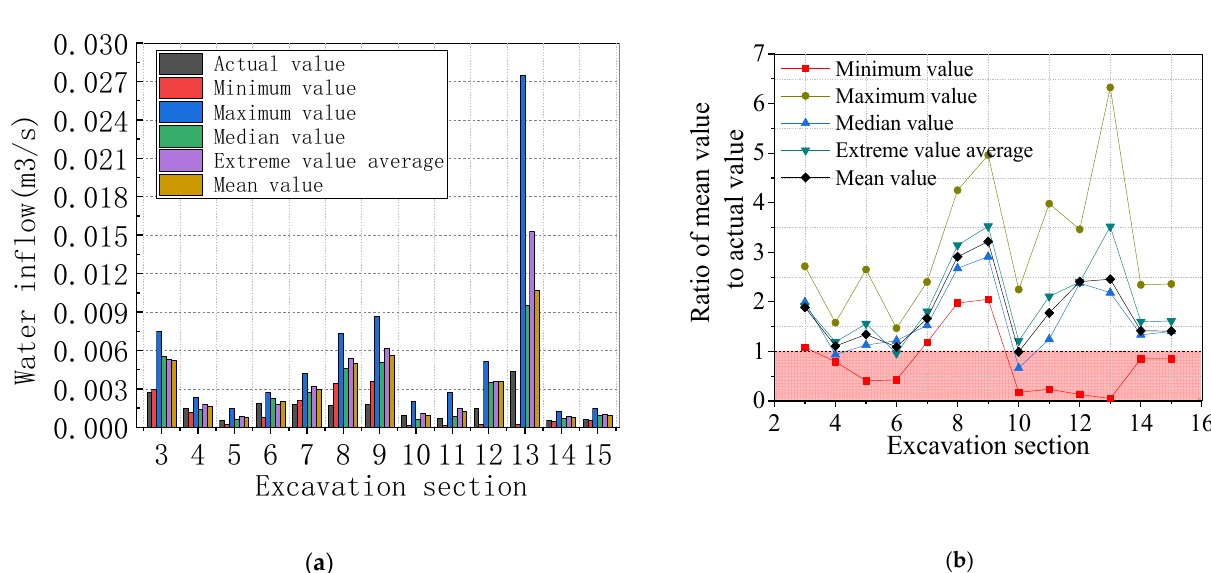
Figure 13. Comparison of theoretical and measured values. ( a ) Comparison of theoretical and measured water inflow under different permeability coefficients; ( b ) Ratio of different theoretical water inflow to measured values. Where 3 stand for ZDDK365+333 to +313, 4 stand for ZDDK365+323 to +313, 5 stand for PDK365+313 to +308 (L), 6 stand for PDK365+316 to +308 (L), 7 stand for PDK365+319 to +308 (L), 8 stand for PDK365+322~+308 (L), 9 stand for PDK365+325 to +308 (L), 10 stand for YPDK365+315.5 to +312.5 (L), 11 stand for YPDK365+317.5 to +312.5 (L), 12 stand for ZDDK365+307.5 to +292.5 (L), 13 stand for ZDDK365+310.5 to +292.5 (L), 14 stand for ZDDK365+290 to +275, and 15 stand for ZDDK365+293 to +275.